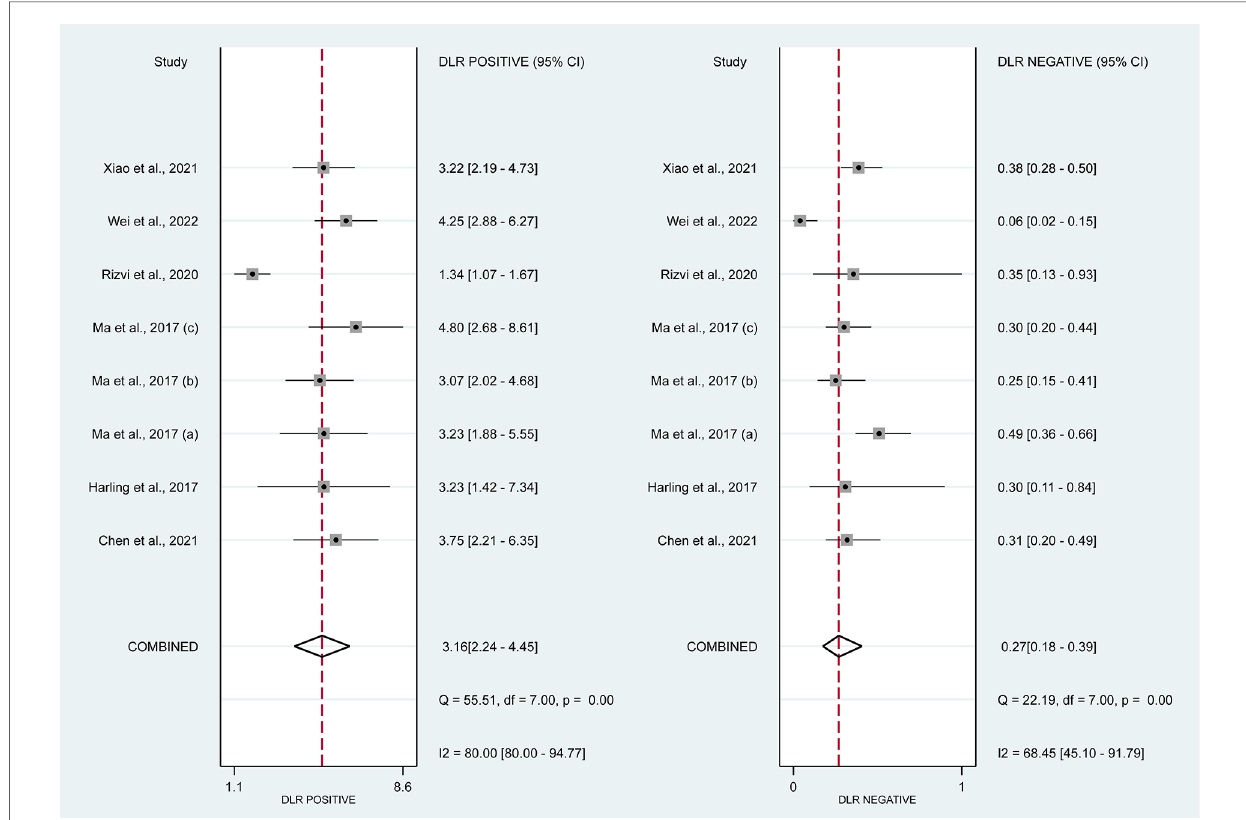
FIGURE 7 Forrest plot of estimates of positive likelihood ratio and negative likelihood ratio. The PLR was 3.16 (95% CI, 2.24 – 4.45; p <0.01) and The DLR was 0.27 (95% CI, 0.18 – 0.39; p